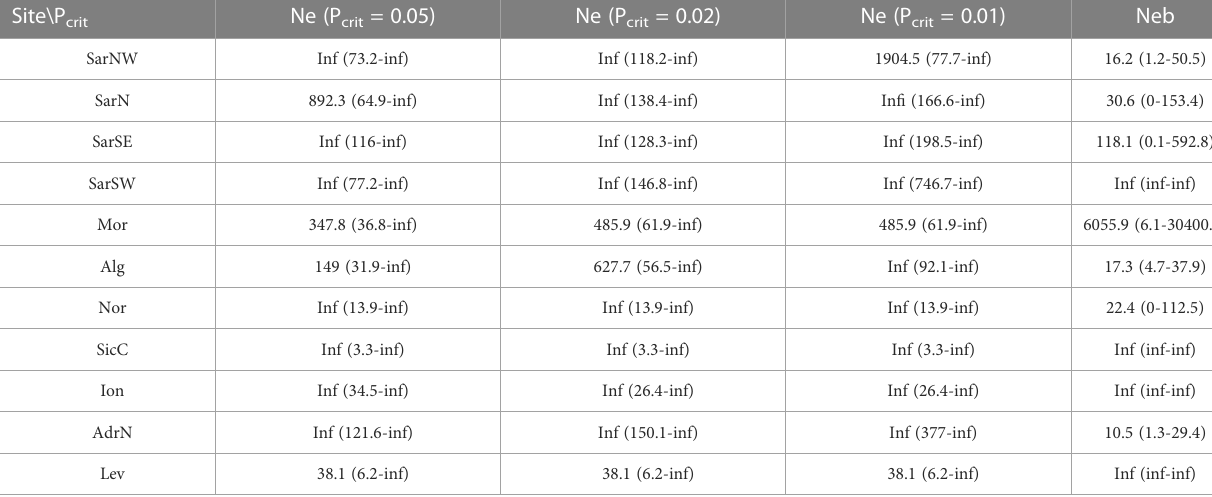
TABLE 4 NEESTIMATOR results for Scyliorhinus canicula populations. Site\P